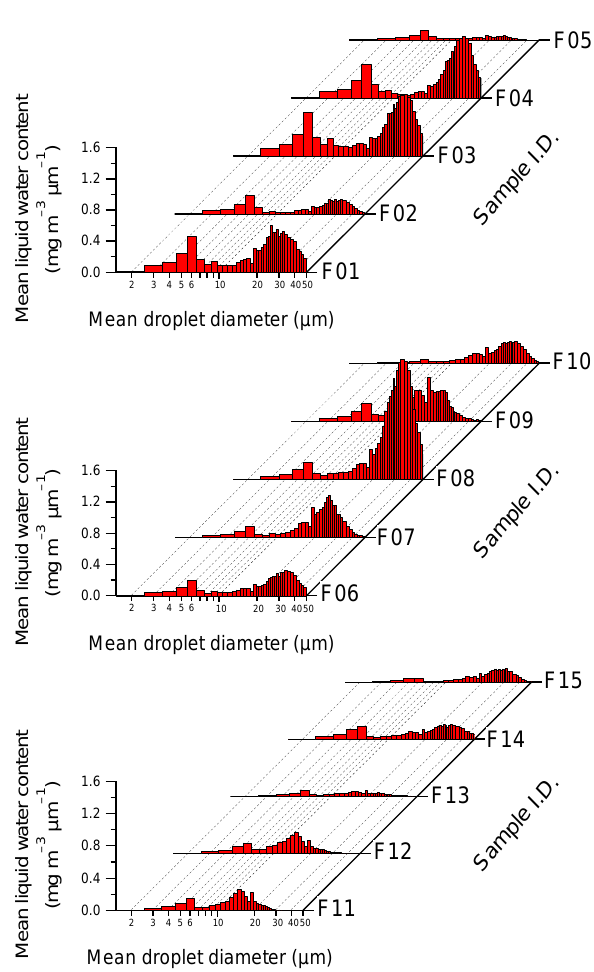
Fig. 8. Variations of mean LWC for each sea fog event as a function Figure 8. Variations of mean LWC for each sea fog event as a function of mean droplet 2 of mean droplet diameter during the diameter during the cruise. 3